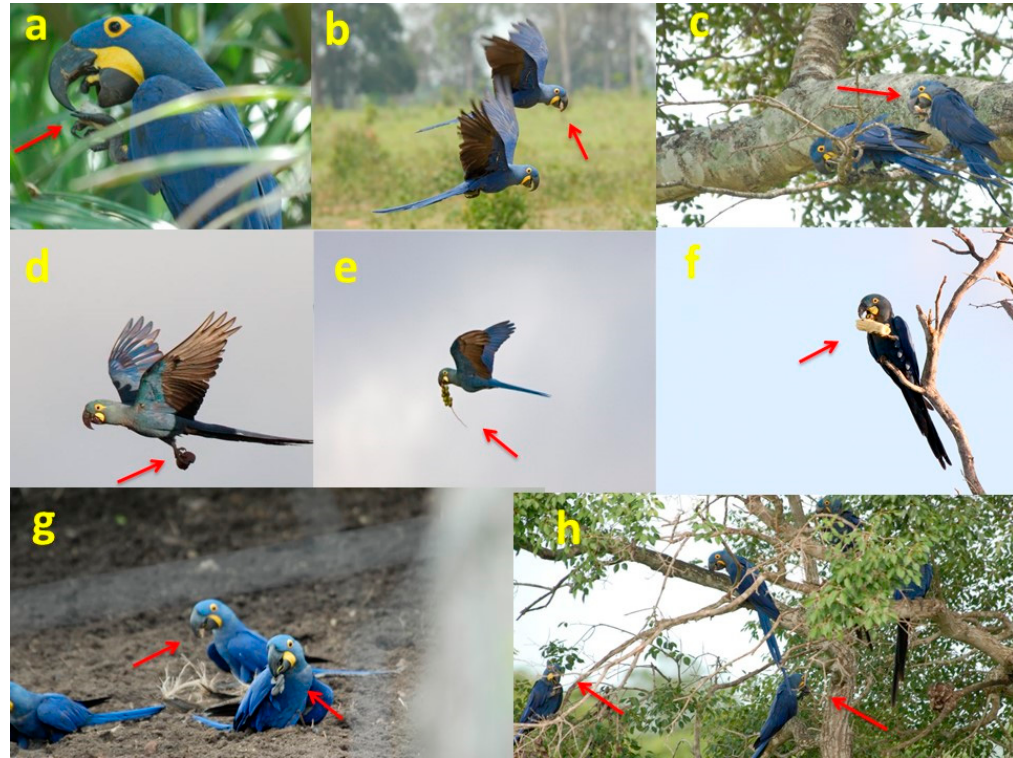
Figure 2. Seed dispersal processes. ( a ) Hyacinth macaw defleshing an Attalea phalerata palm fruit; the macaw dropped the fully defleshed but undamaged nut under the same mother palm tree. Primary dispersal: ( b ) one hyacinth macaw flew a minimum distance of 160 m carrying a defleshed A. phalerata fruit to be handled, ( c ) in a perching tree. Large cactus fruits are carried by foot ( d ), while a bunch of fruits of Syagrus coronata palm is carried by beak ( e ) by Lear’s macaws. ( f ) A corn cob dispersed by Lear’s macaw is handled in a perching tree. Tertiary dispersal: ( g ) Hyacinth macaws picked A. phalerata and Acrocomia totai nuts from the ground after regurgitation by cattle and flew 80 m to a perching tree ( h ) to handle them and consume the seeds. Some undamaged nuts were dropped under perches. Photographs taken by J.L. Tella (a,b,c,g,h), Steve Brookes (d), and Ciro Albano